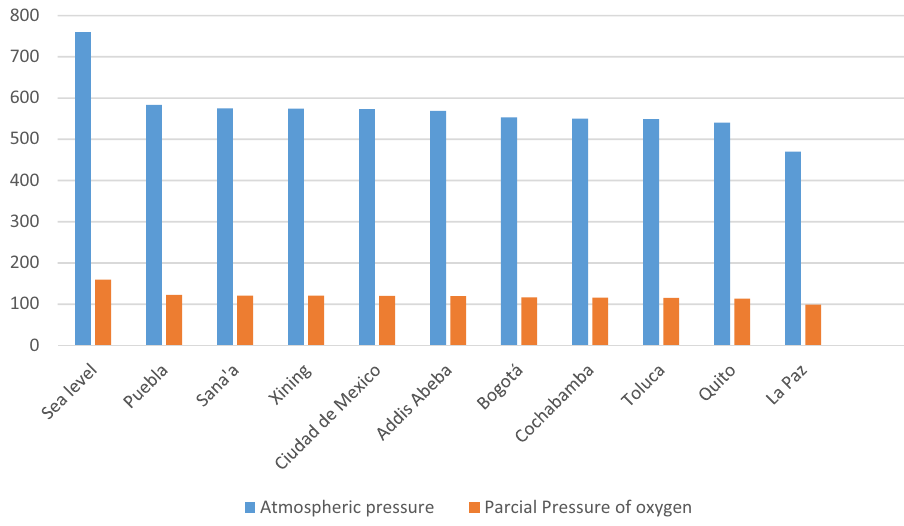
Figure 1. Atmospheric pressure and partial pressure of oxygen according to the altitude where the population is located.